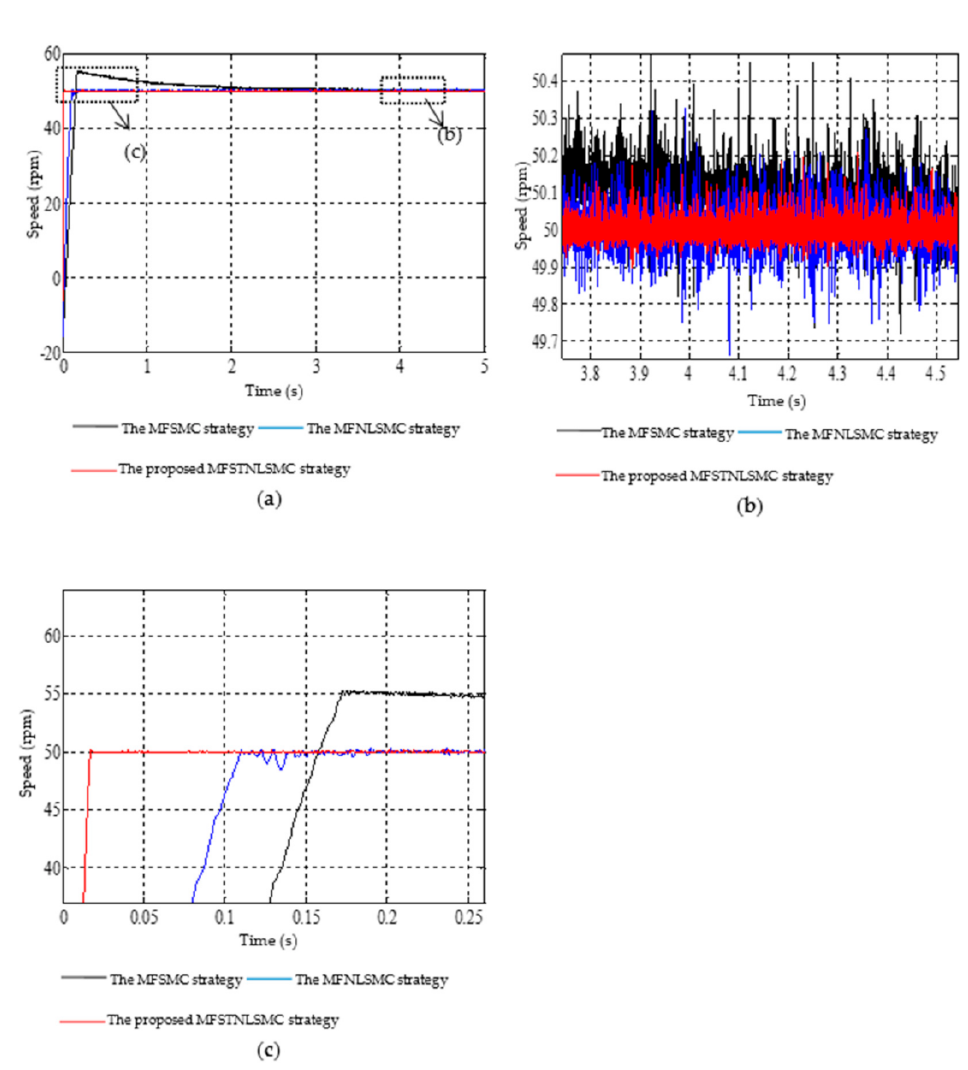
Figure 5. ( a ) Speed response curves with 2N · m load; ( b ) Detailed view of the image ( a ); ( c ) Detail of the beginning of the image ( a